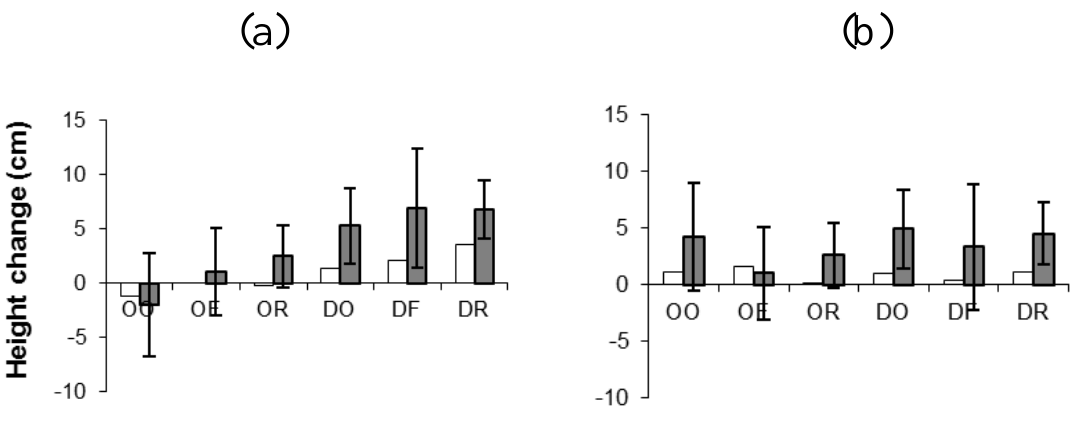
Figure 10. Five-year and ten-year change in ground surface height (unfilled and filled bars, respectively) in response to the different treatments for (a) the section of the monitoring transect within the treatment plot, and (b) the adjacent open bog 1–10 m outside the former forest edge. The error bars are 95 % confidence intervals (n = 6).